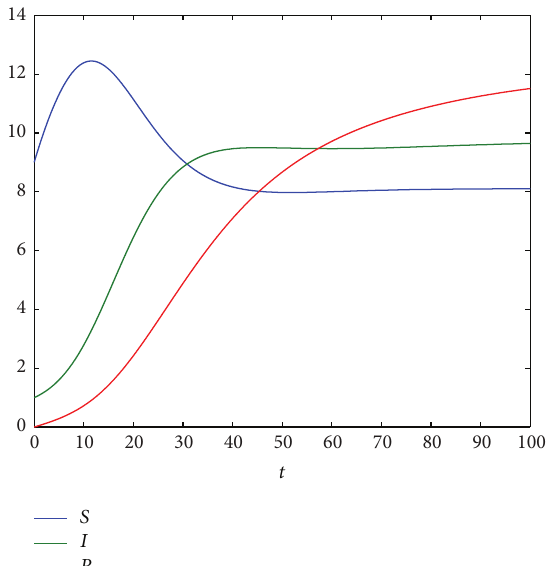
Figure 1: The paths of 𝑆(𝑡) , 𝐼(𝑡) , and 𝑅(𝑡) for the deterministic model (1) with initial values (𝑆(0),𝐼(0), 𝑅(0)) = (9,1, 0) . The parameters are taken as (41) ( 𝑅 0 = 7.407 ).